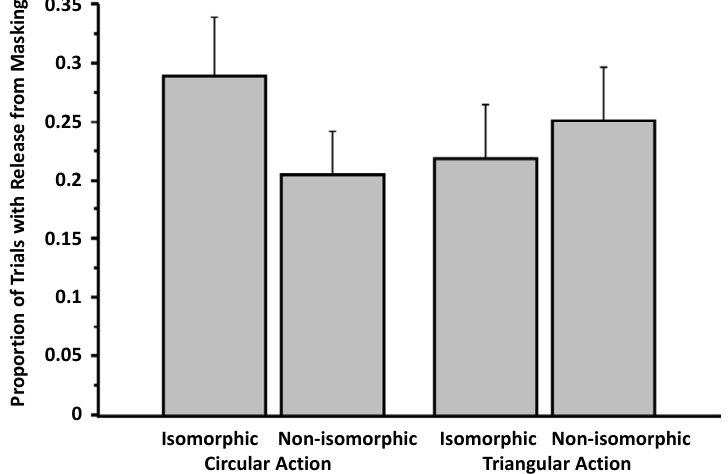
Figure 6. Proportion of trials involving release from masking as a function of action and isomorphism (Experiment 3). The data are culled from the question, “Did you see anything on the screen other than the pattern mask?” Error bars signify SEMs.